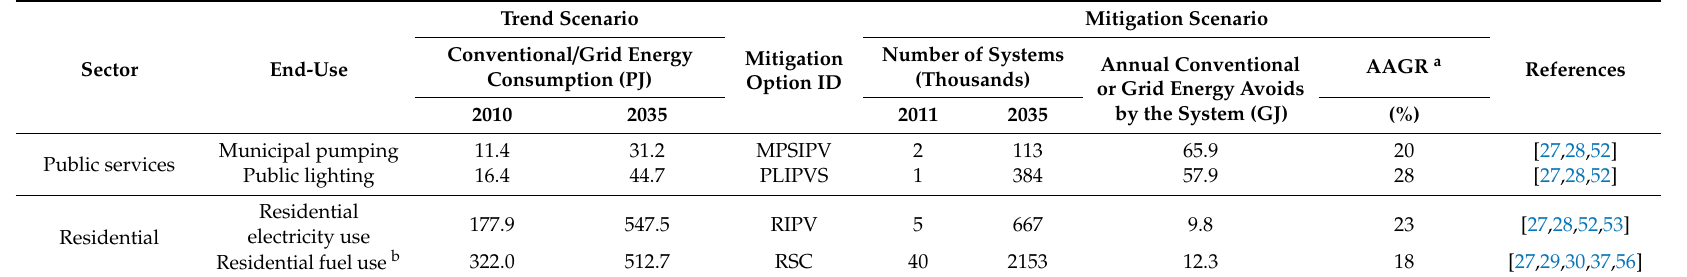
Table 3. Specific assumptions of solar energy options in the mitigation